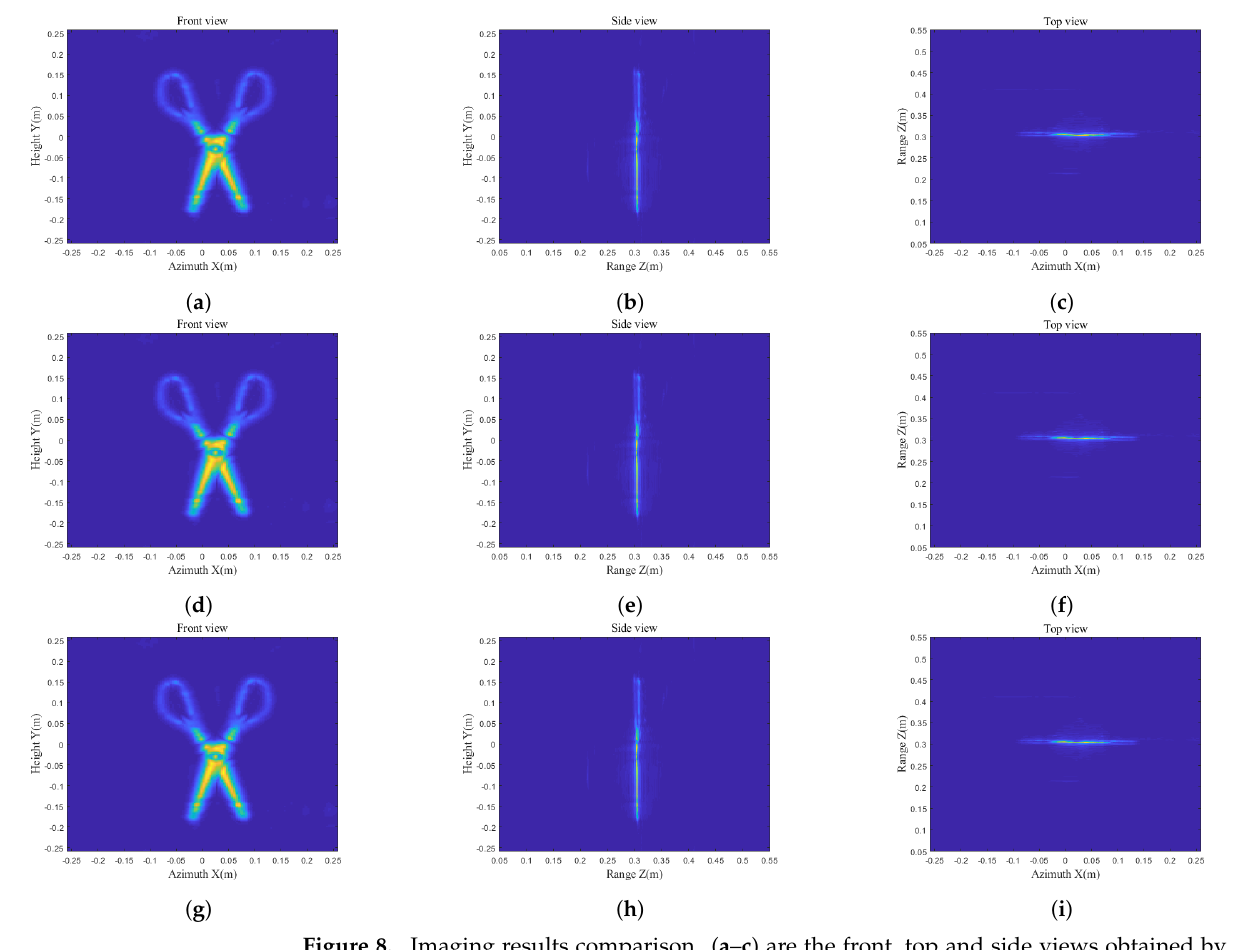
Figure 8. Imaging results comparison. ( a – c ) are the front, top and side views obtained by CPU- only method, respectively; ( d – f ) are the front, top and side views obtained by GPU-only method, respectively; ( g – i ) are the front, top and side views obtained by the proposed method, respectively